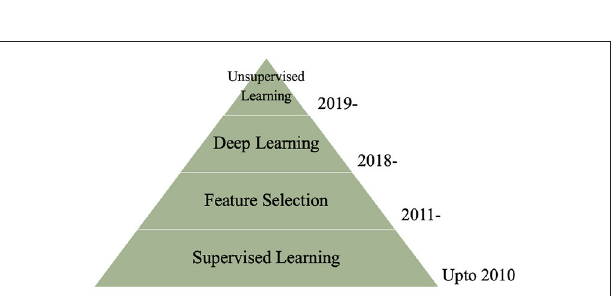
FIGURE 5 | Trends in machine learning for HRV